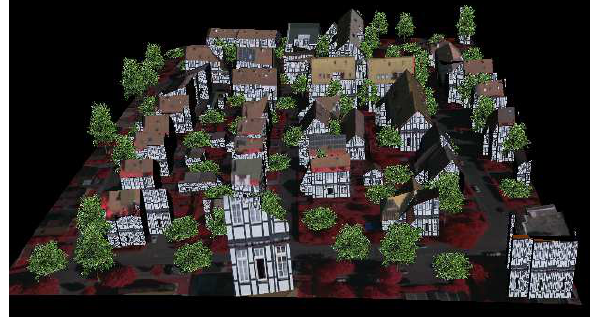
Figure 10: Reconstruction result for the data set Vaihingen